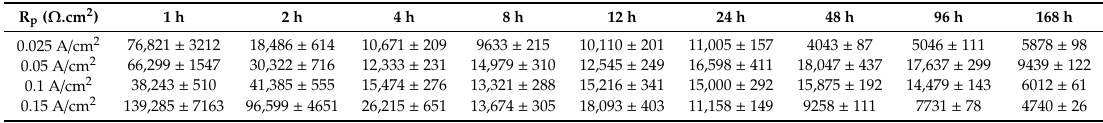
Figure 8. Nyquist diagrams of PEO coatings prepared in the electrolyte with 8 g / L Na 3 PO 4 with different applied current densities after 1 h ( a ) and 168 h ( b ). Table 8. Values of R p of PEO coatings prepared in the electrolyte with 8 g / L Na 3 PO 4 with various applied current densities measured in 0.1 M NaCl .